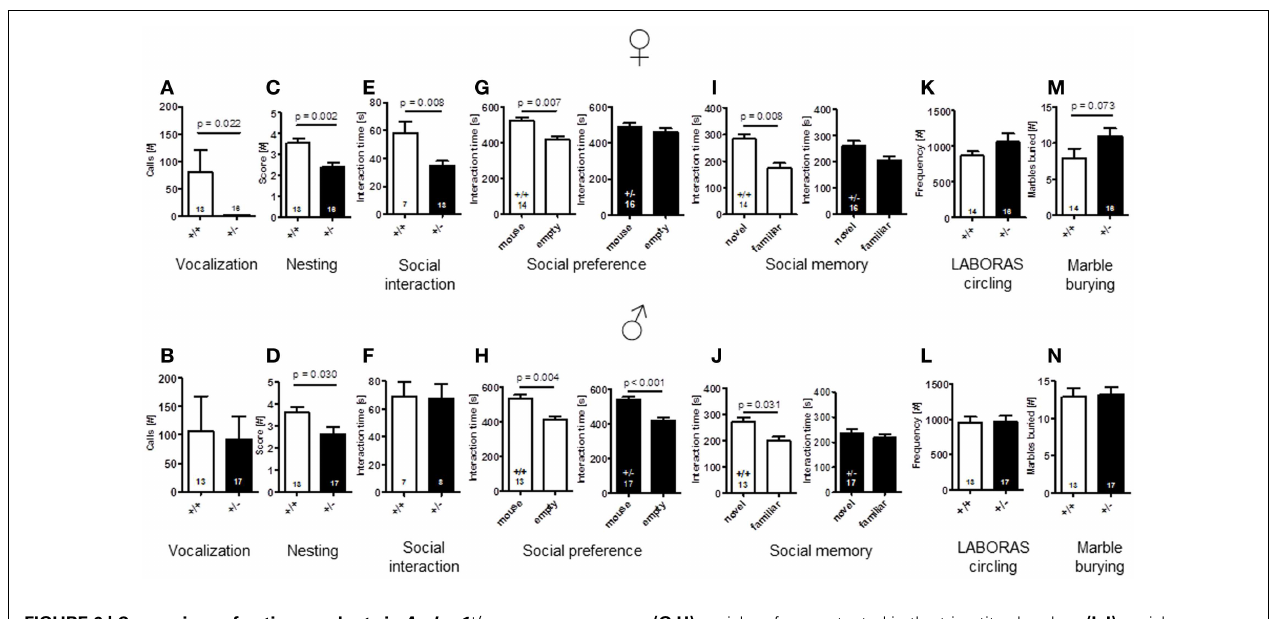
FIGURE 6 | Comparison of autism-readouts in Ambra1 + / − versus Ambra1 + / + mice of both genders discloses an autism-like phenotype in female Ambra1 + / − mice .The upper row presents results for female, the lower row for male mice. (A,B) Communication: ultrasound vocalization; (C,D) social competence: nesting score; (E,F) social interaction in pairs;